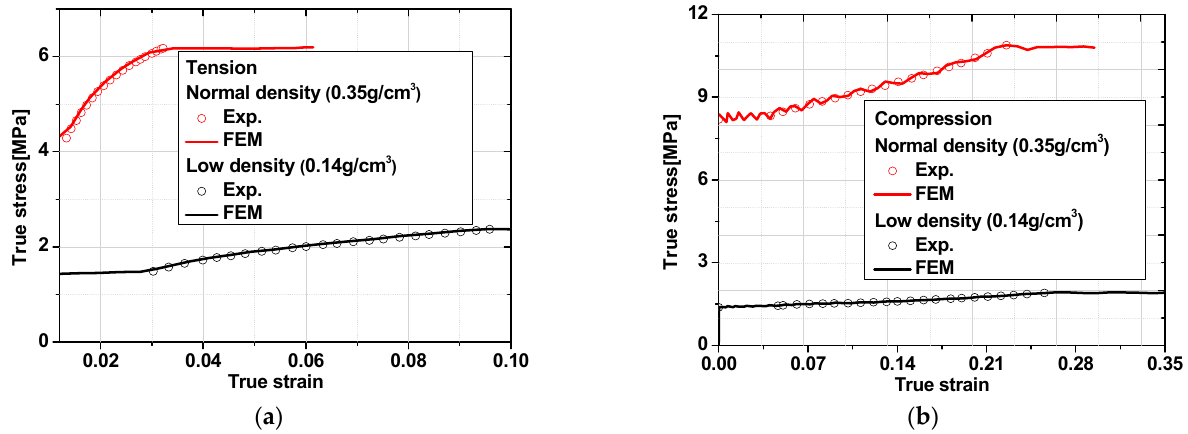
Figure 10. Comparison of experimental and analysis results using concrete damaged plasticity model with respect to foam density in: ( a ) tension; ( b ) compression.